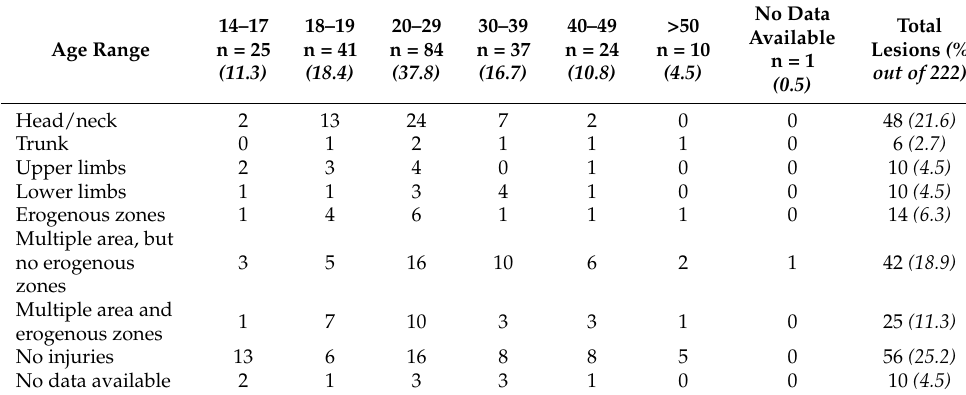
Table 3. Body areas reporting lesions, stratified by age group.